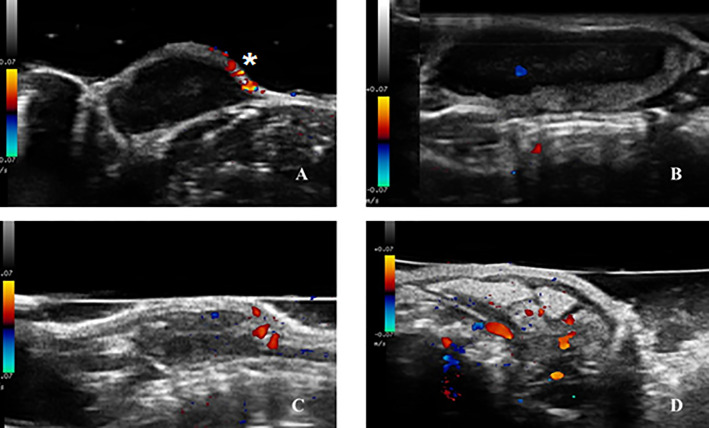
Color Doppler mode ultrasound images of Ehrlich Solid Carcinoma induced in the subcutaneous tissue of Swiss albino mice; showing in (A) tumor without vascular flow, the signals of flow in the skin marked with (*) are not considered tumor flow; (B) image with a single intratumoral vessel with central distribution flow pattern; (C) image with four intratumoral vessels with peripheral distribution flow pattern; (D) image with more than five intratumoral vessels with mixed distribution flow pattern.